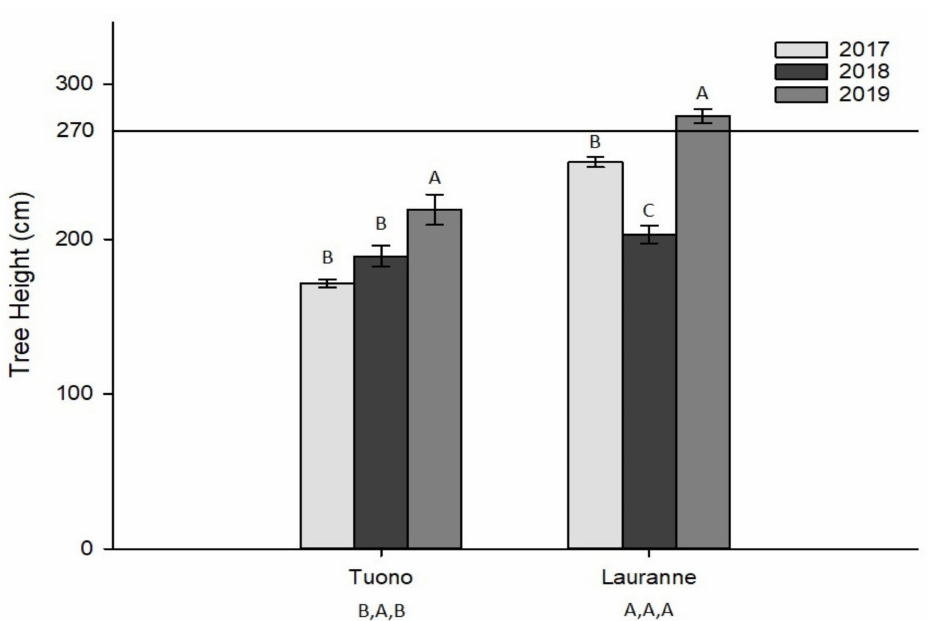
Figure 5. Tree height (cm) of cultivars Tuono and Lauranne in three subsequent years (2017–2019). The letters on the bars denote statistical differences among the years for each cultivar; the letters on the x-axis denote statistical differences between cultivars for each year (SNK test). Letters denote statistical differences at p = 0.01. The horizontal line set at 270 cm indicates the threshold